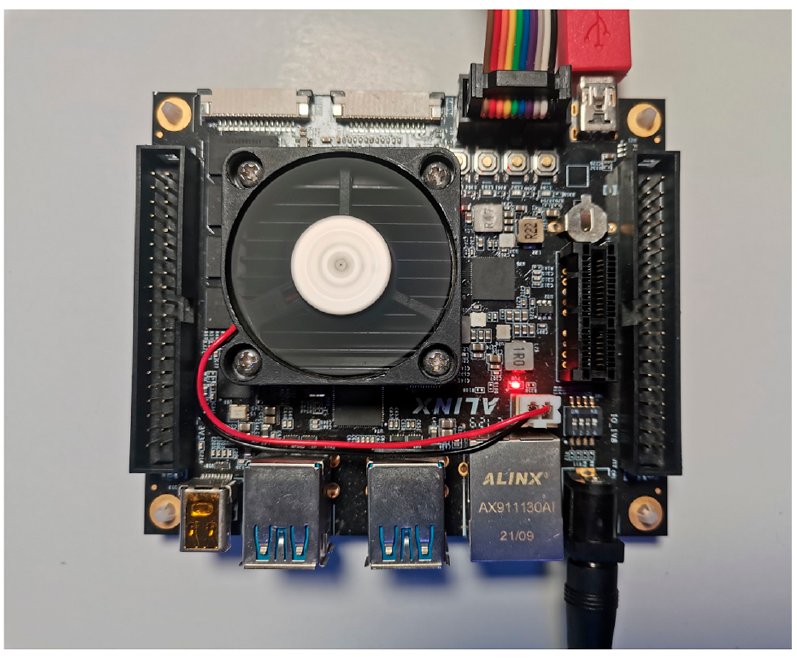
Figure 1. The AXU2CGB development board.